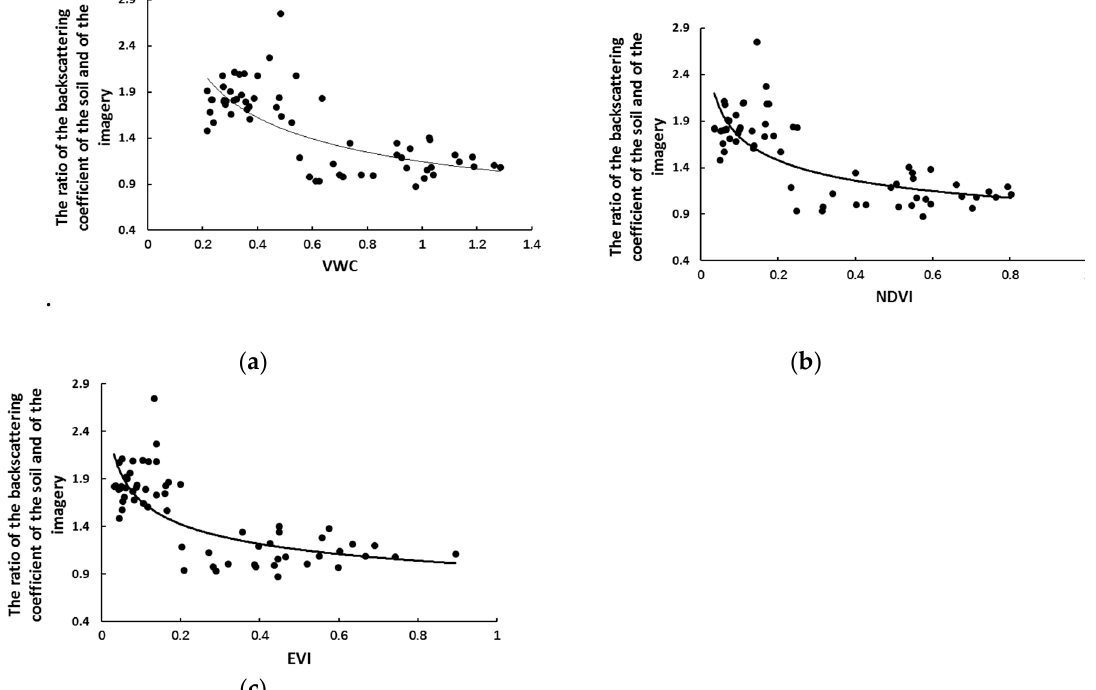
Figure 7. The ratio scatter plots of 𝜎 (cid:3049)(cid:3049)(cid:3046)(cid:3042)(cid:3036)(cid:3039)(cid:3042) /𝜎 (cid:3049)(cid:3049)(cid:3042) to vegetation indices ( a ) VWC; ( b ) NDVI; ( c ) EVI. Figure 7. The ratio scatter plots of σ o / σ o vv to vegetation indices ( a ) VWC; ( b ) NDVI; ( c ) EVI. vvsoil Table 2. The fitting result of the unknown coe ffi cient of the ratio equation. Vegetation Indices